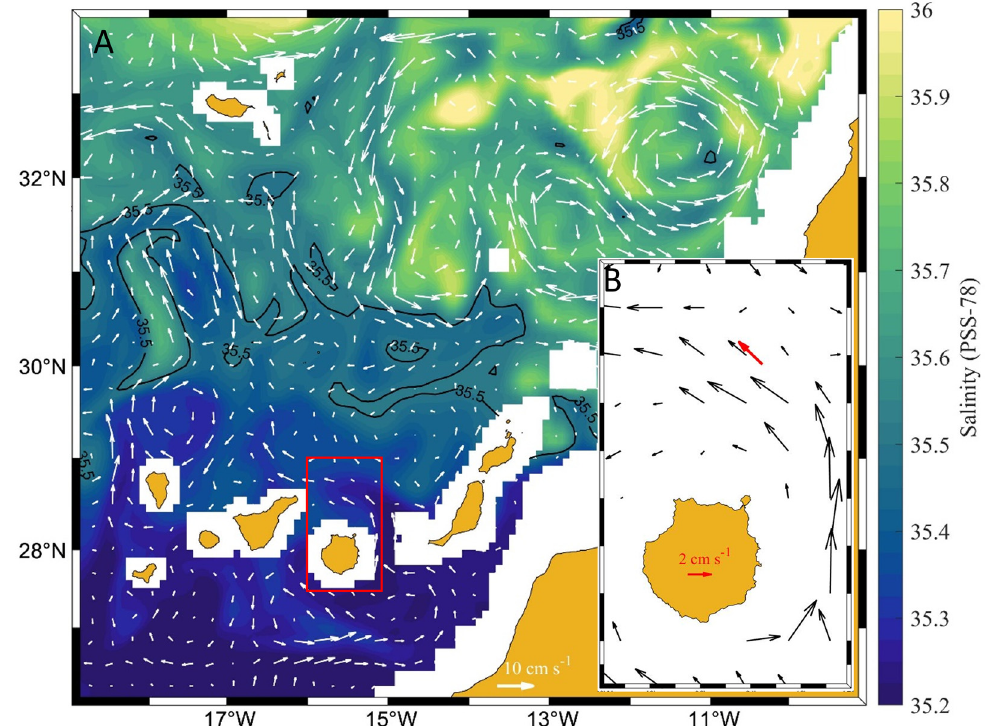
Figure 9. Salinity and currents fields at 900 m depth obtained from the IBI reanalysis for 30 April 2016. The red box area is shown in more detail at the inset, where the current derived from the glider trajectory for the same day (red arrow) is represented along with the IBI current velocity field.